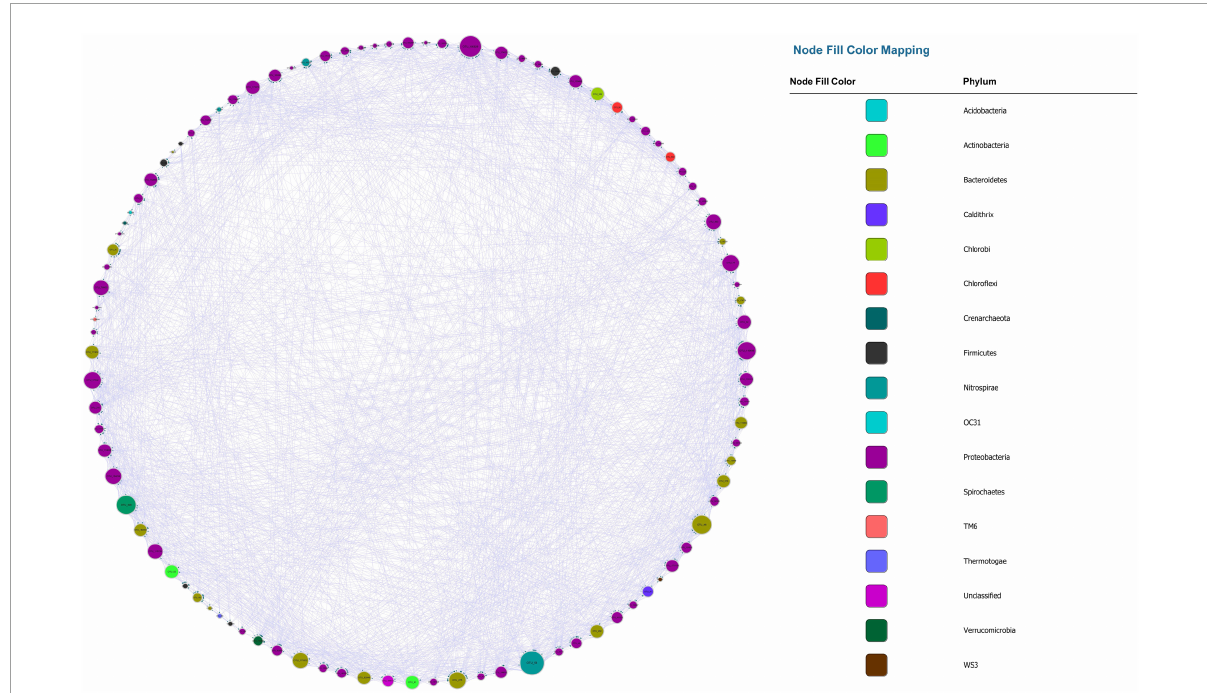
FIGURE1 Microbial Granger Causal Network, each color represents a separate phylum. The size of the node and node label is proportionate to the edge number of each node from 0 to 110. The arrows represent the direction of Granger causality.